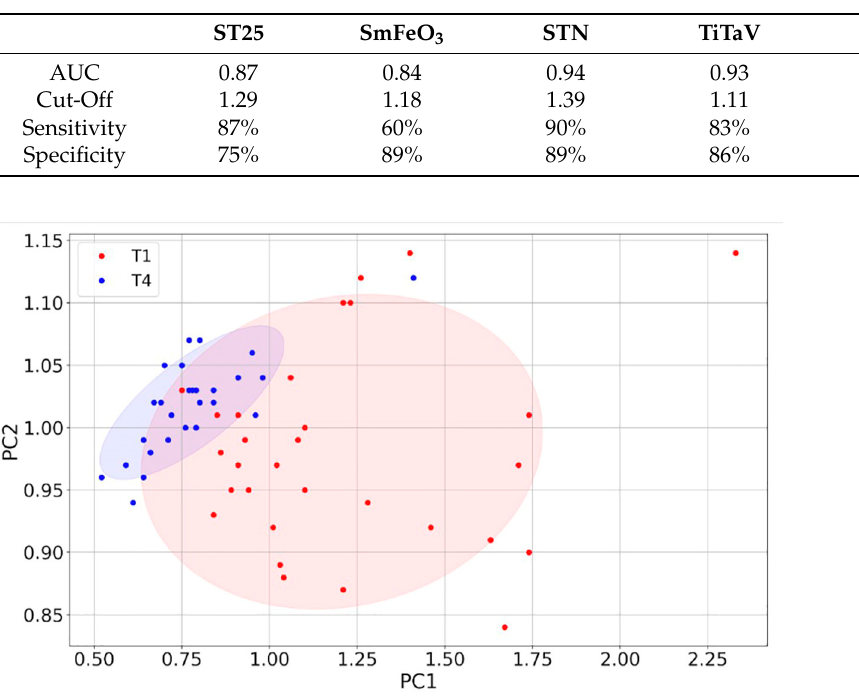
Figure 8. PCA of sensor responses. Score plot of PC1 vs. PC2 (red points: T1; blue points: T4) constructed with the responses ( n = 58) of the four sensors.